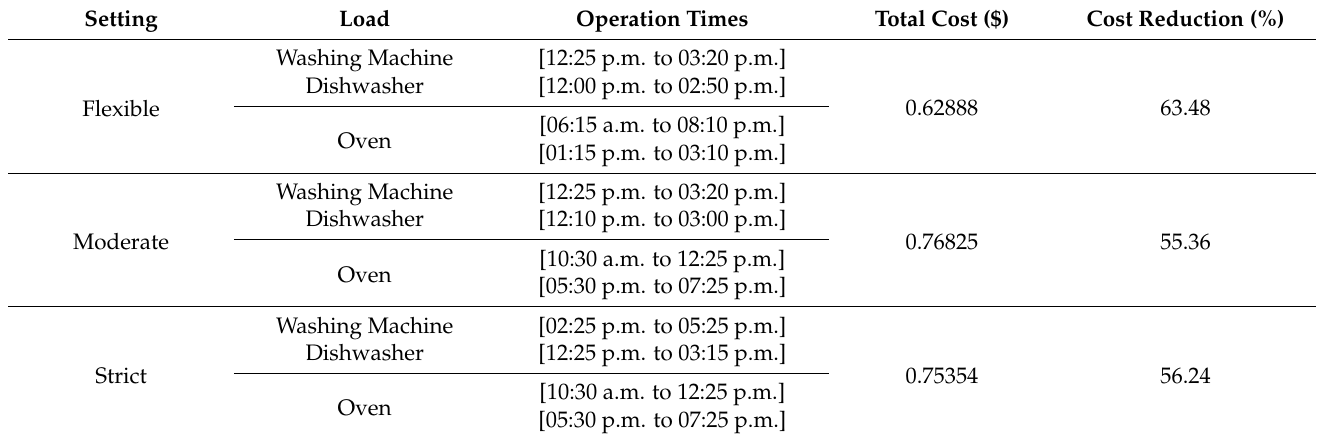
Table 6. Result Summary for Scenario